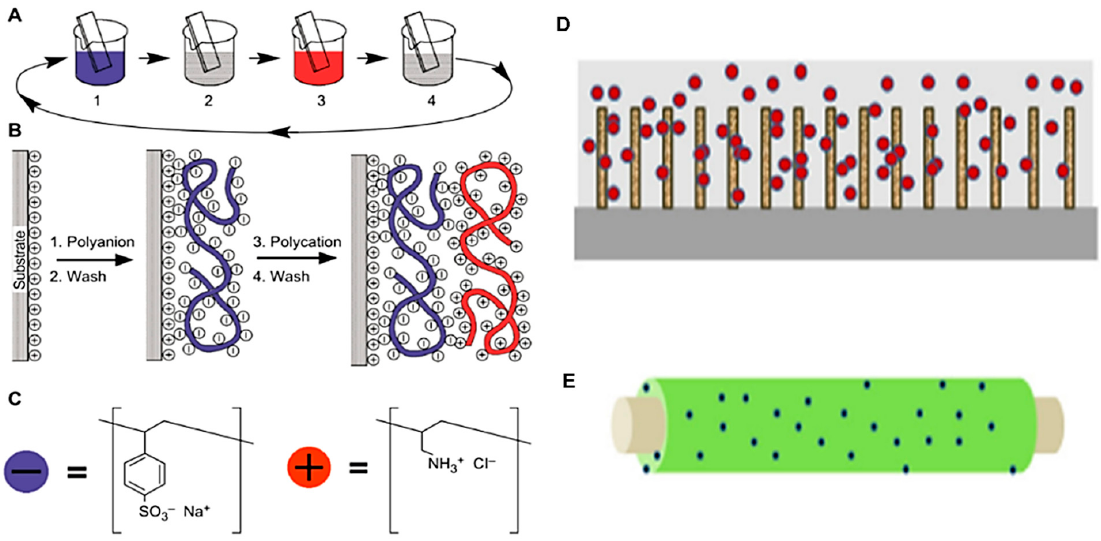
Figure 5. ( A – C ): Schematic of a layer-by-layer film coating procedure; steps 1 and 3 represent the adsorption of a polyanion and polycation, respectively, and steps 2 and 4 are washing steps [82]. ( D , E ): Examples of film casting and dip coating [4]: silicon wafer; ( E ) dip-coating in lactose-modified chitosan and embedding Ag nanoparticles (spheres) on the thermoset